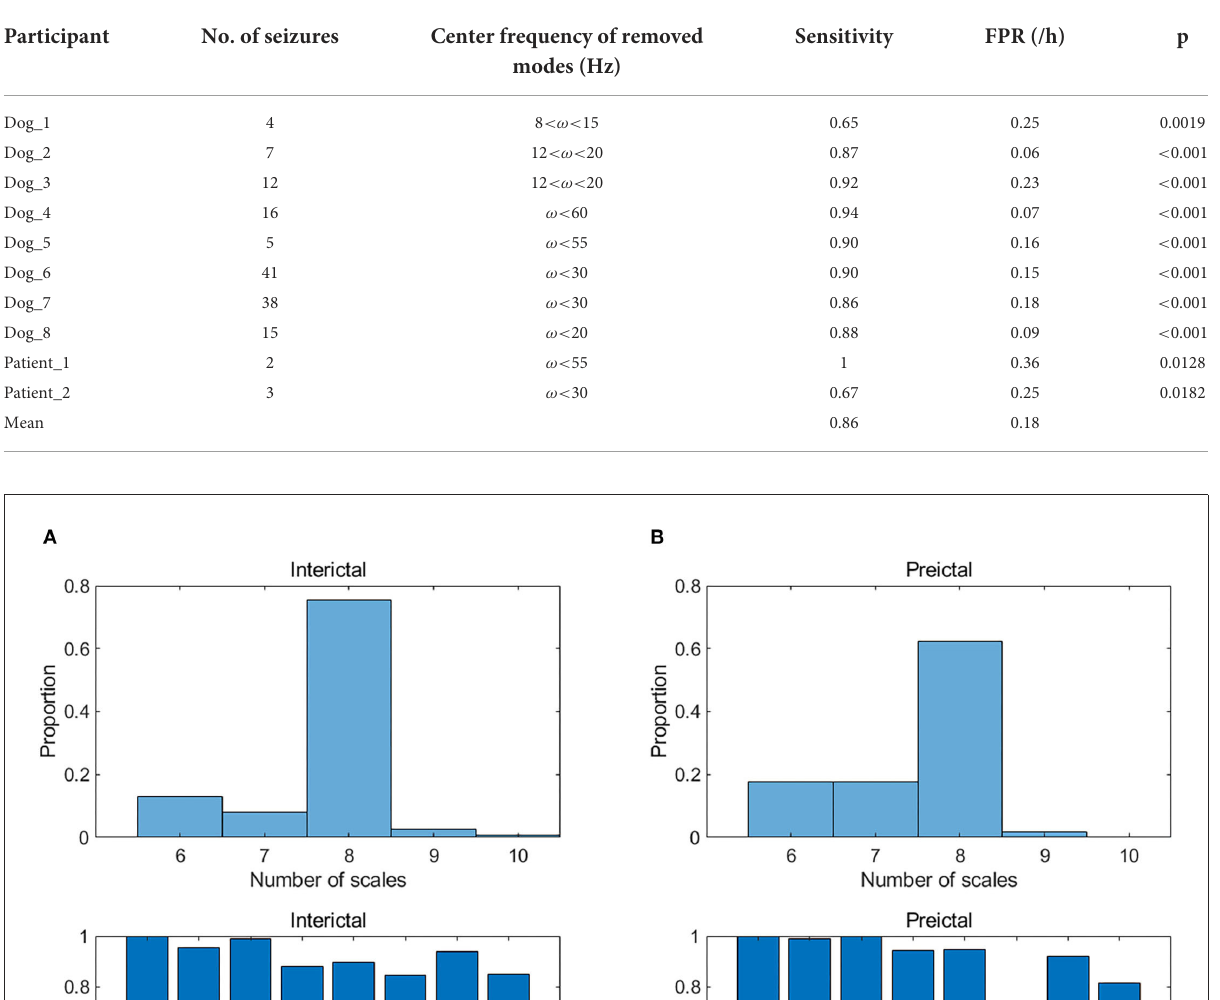
of Dog_5 for example, the distribution of the number of time scales and center frequency on 8 dominant scales are displayed in Figure 3. Most of the interictal samples (75.6%) were decomposed into 8 scales of band-limited intrinsic mode function (BIMF), whereas there was less consistency for preictal samples on the number of modes. For both states, the center frequencies of 8 dominant time scales were in the range of [0,